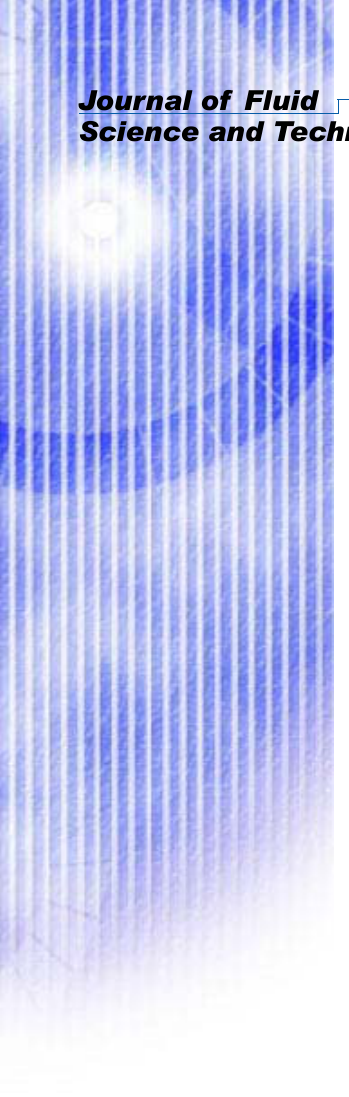
Fig.9-2 Calculated Sound Pressure